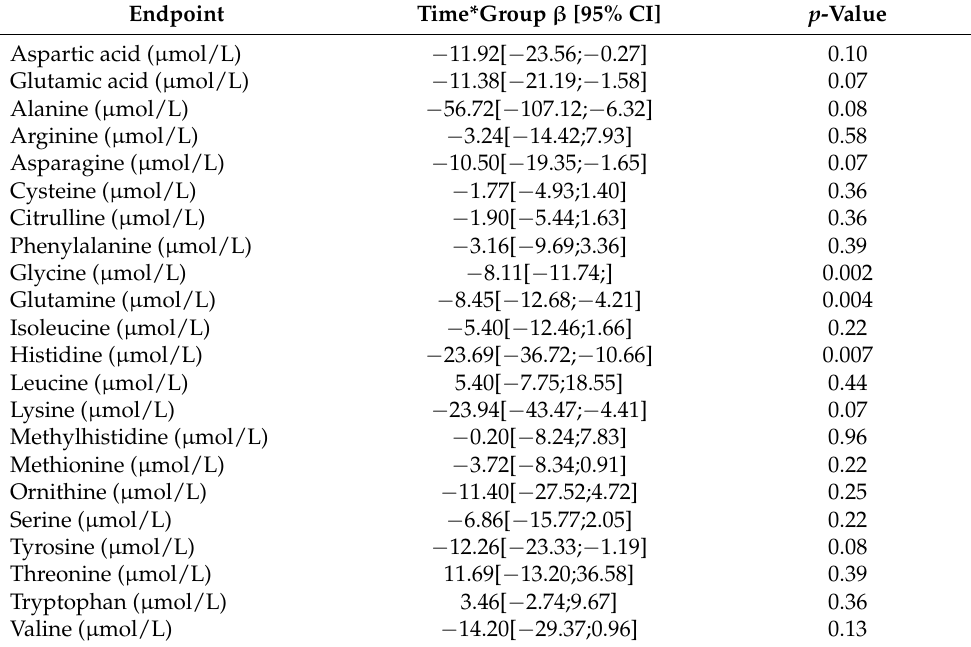
Table 6. Between-group differences for plasma amino acids and metabolites—estimates ( β ) of time*group, 95% confidence intervals (CI), and adjusted p -values of the null hypothesis of β = 0 for the 22 amino acids.